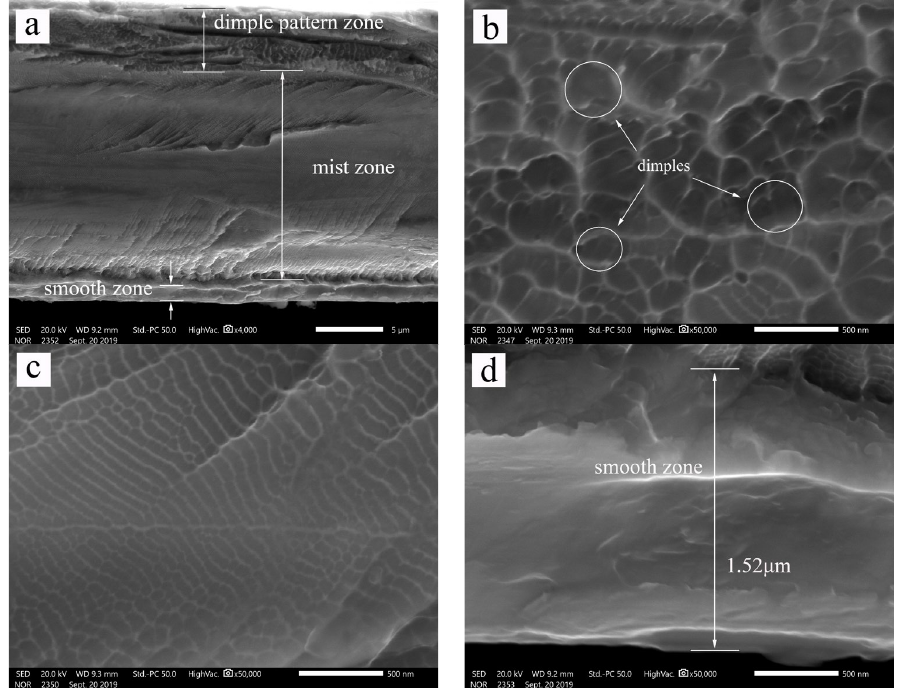
Figure 6. Fracture surfaces for S250 : overview of fracture surface ( a ); enlarged images for dimple ( b ); mist zone ( c ); smooth zone ( d ).